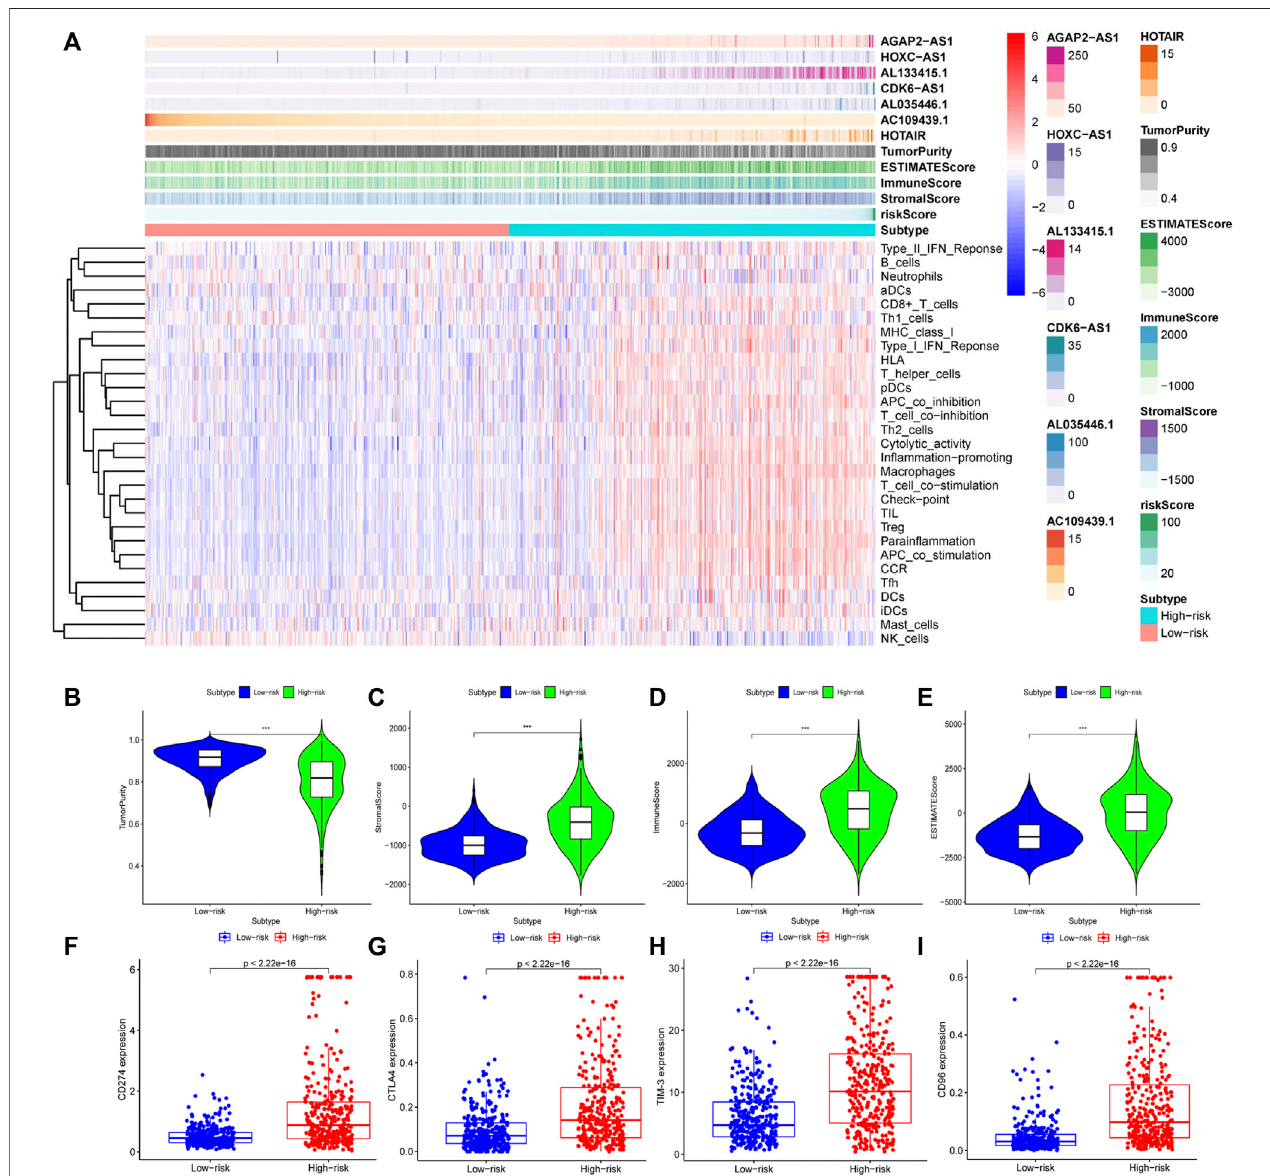
FIGURE 7 | Relationship between GILncSig and the tumor immune microenvironment. (A) Heatmap of glioma immune microenvironment based on the GILncSig score. Quantitative analysis of glioma microenvironment and related indicators: tumor purity (B) , StromalScore (C) , immuneScore (D) , and ESTIMATEScore (E) . Expression levels of immune checkpoints in the high- and low-risk groups: CD274 (F) , CTLA4 (G) , TIM-3 (H) , and CD96 (I)